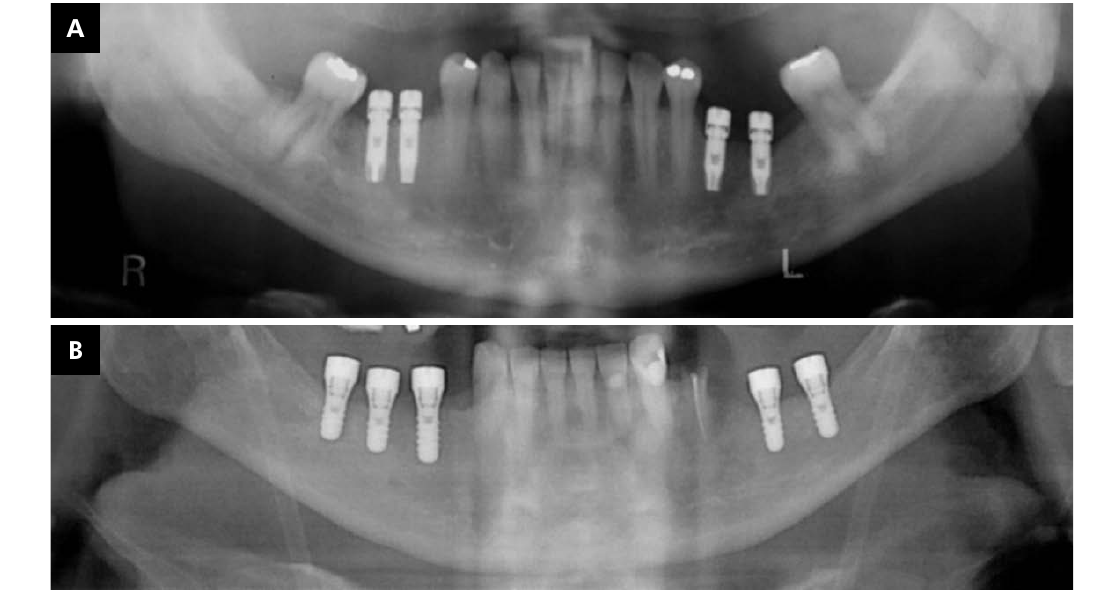
Figure 1. Split-mouth clinical design: a.) Osseotite x Nanotite; b) SLA x